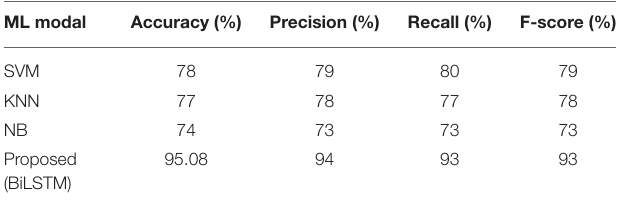
TABLE 3 | Classifiers based on machine learning vs. suggested model (BiLSTM).